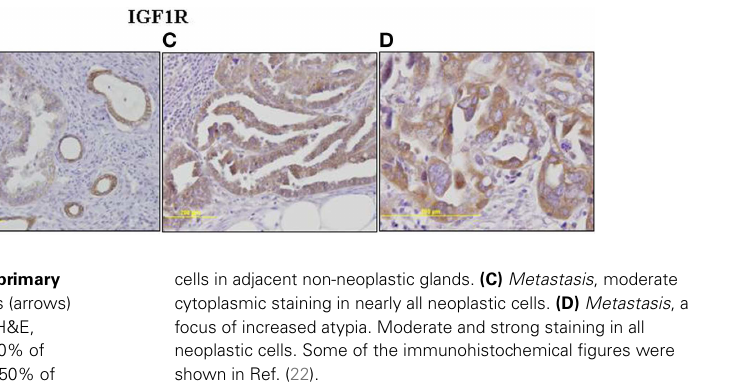
FIGURE 1 | Immunohistochemical staining of IGF1R in primary and metastatic USC . (A) Primary tumor , neoplastic glands (arrows) adjacent to non-neoplastic endometrial glands (asterisks). H&E, × 200. (B) Primary tumor , weak cytoplasmic staining in < 50% of cells (grade II) in neoplastic glands. Moderate staining in > 50% of